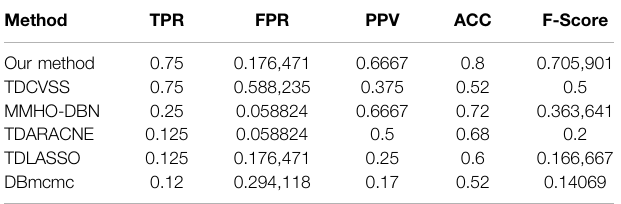
TABLE 3 | Performance comparison of six methods for IRMA network inference with the off